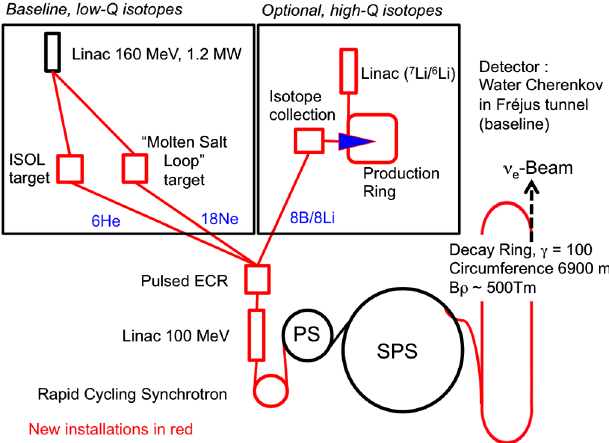
FIG. 1. Layout of the CERN beta beam. Two beta emitting isotope pairs are considered: 6 He = 18 Ne (low- Q ) and 8 Li = 8 B = ¯ ν (high- Q ) for ν production respectively. The decay ring has e e similar dimensions for the two isotope pairs. The inclination angle is 0.6° for a neutrino beam pointing at the Fréjus detector and 3° for a neutrino beam from CERN to Gran Sasso in Italy, or Canfranc in